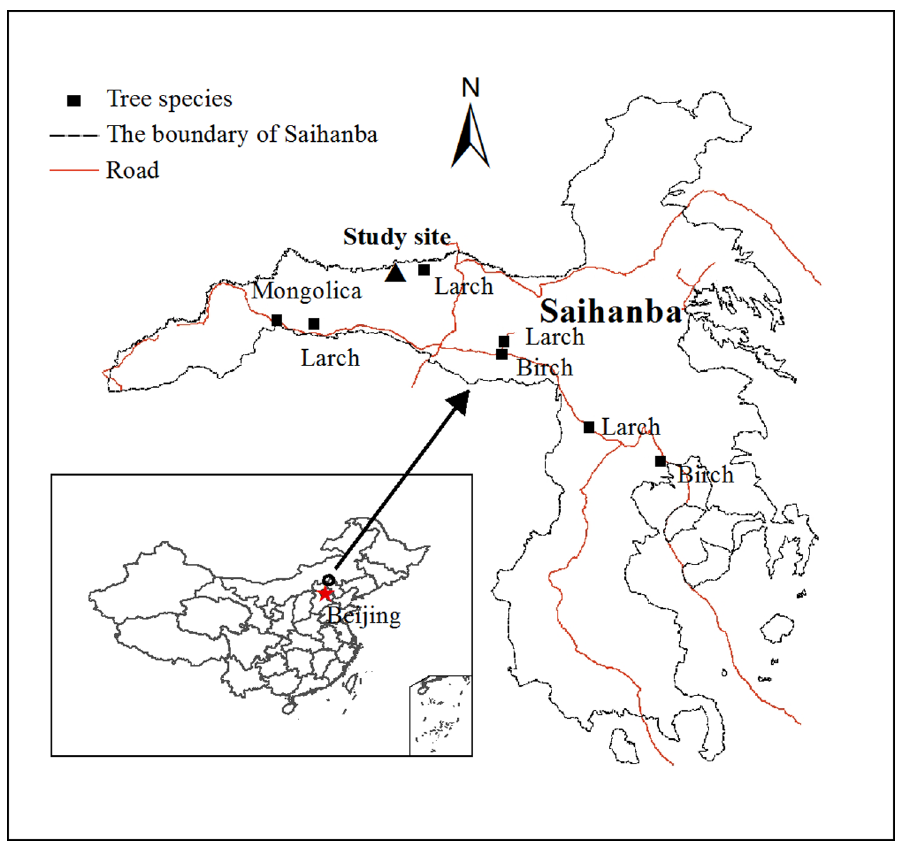
Figure 1. Location of study site in Saihanba National Forest Park, Hebei Province, China.